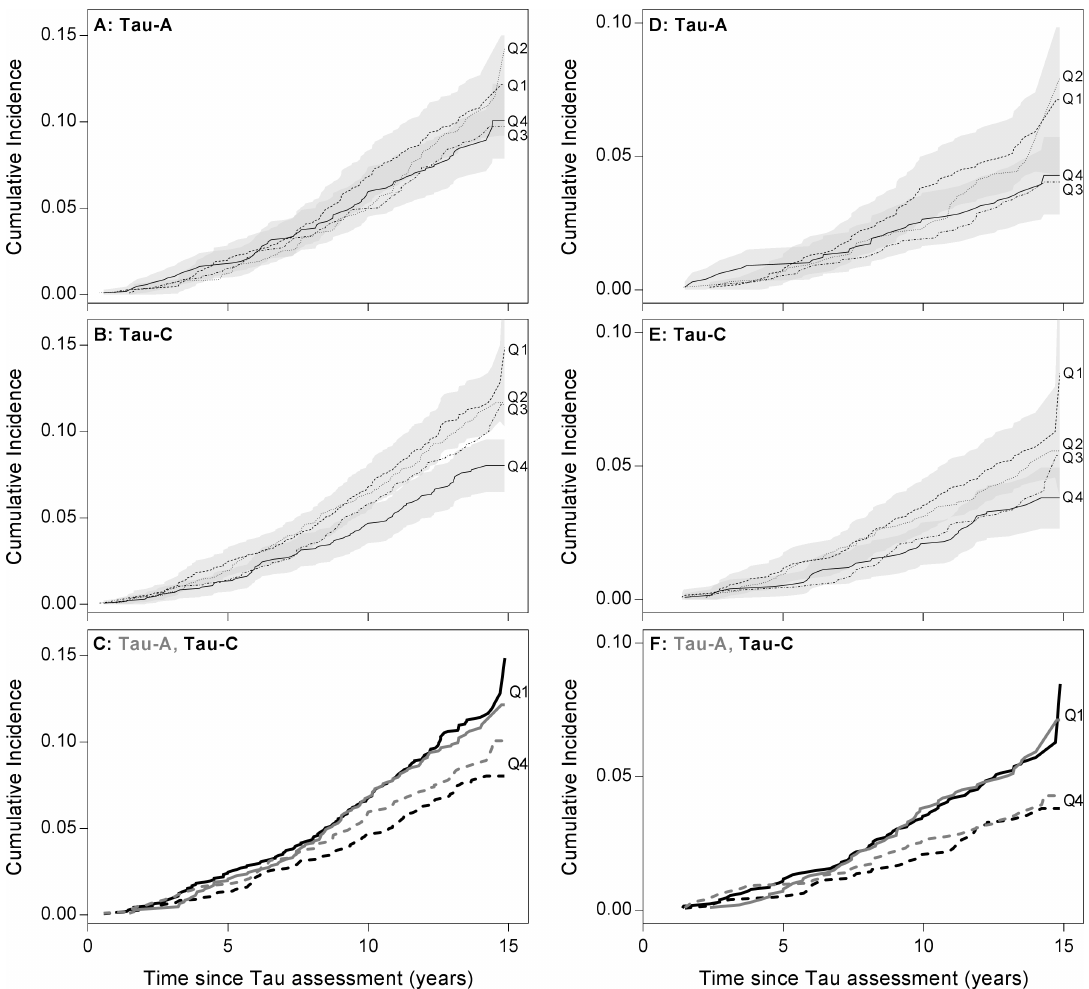
Fig 1. Cumulative incidence curves. Cumulative incidence in quartiles of Tau-A and Tau-C as a function of follow-up time. Left panel (A-C) illustrates the cumulative incidence for all-cause dementia. Right panel (D-F) illustrates the cumulative incidence for AD. The bottom graphs (C and F) are overlay plots of Tau-A and Tau-C showing only Q1 and Q4 for both markers. Confidence intervals (95%) are shown for the lowest (Q1) and highest quartiles (Q4) in A, B, D and